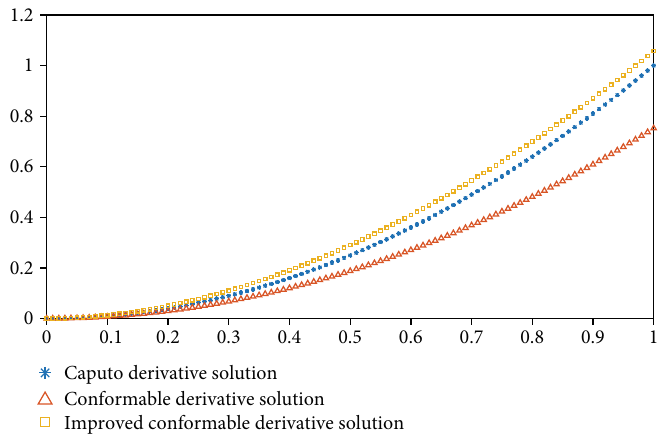
Figure 10: Solution to Example